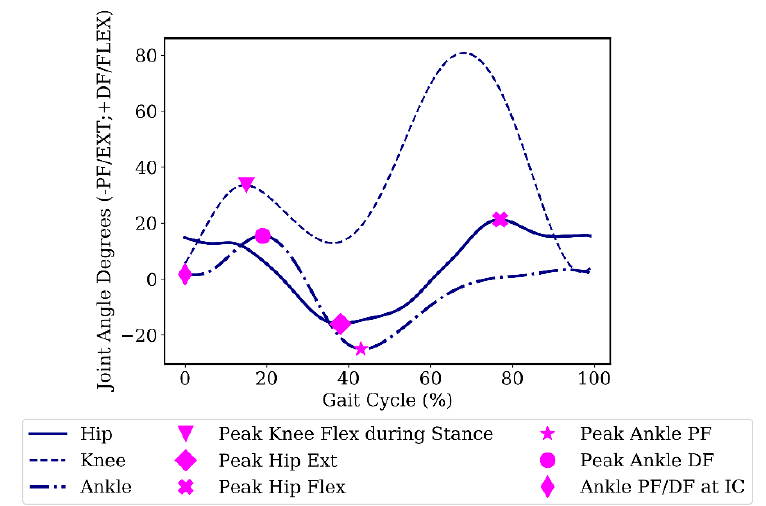
Figure 4. Gait events over a sample participant’s gait cycle. Flexion (Flex) / Dorsiflexion (DF) are positive; extension (Ext) / Plantarflexion (PF) are negative. IC, initial contact.